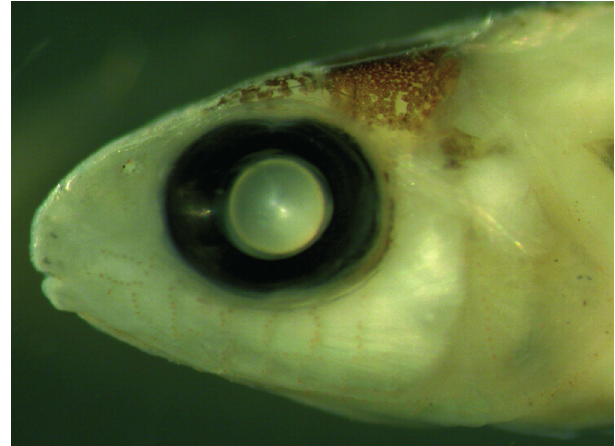
Fig. 3. Posterior caudal vertebrae and associated bone ele- ments of Amazonspinther dalmata (left side view) (MCP 37572, 14.98 mm SL, c&s).